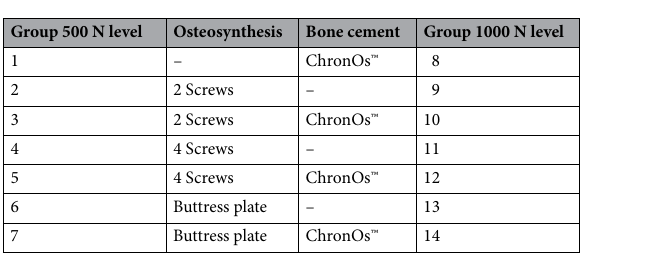
Table 1. The fourteen test groups are shown: Seven different stabilization techniques were tested in two different cyclic loading protocols, one with 500 N loading and one with 1000 N loading.